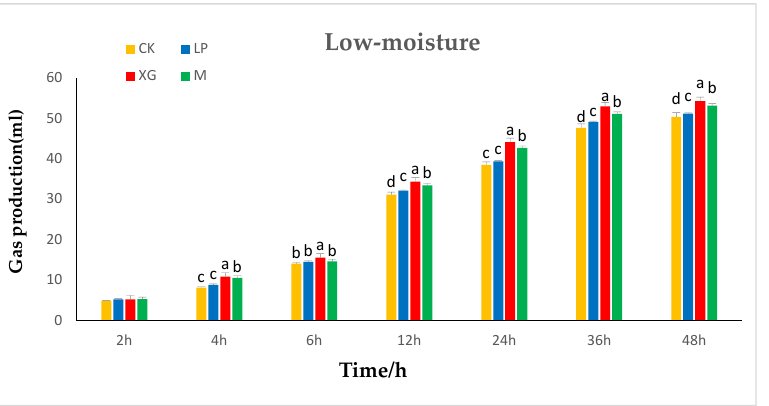
Figure 2. Effects of additives on the in vitro gas production in rumen of low-moisture content Stylosanthes silage. Stylosanthes